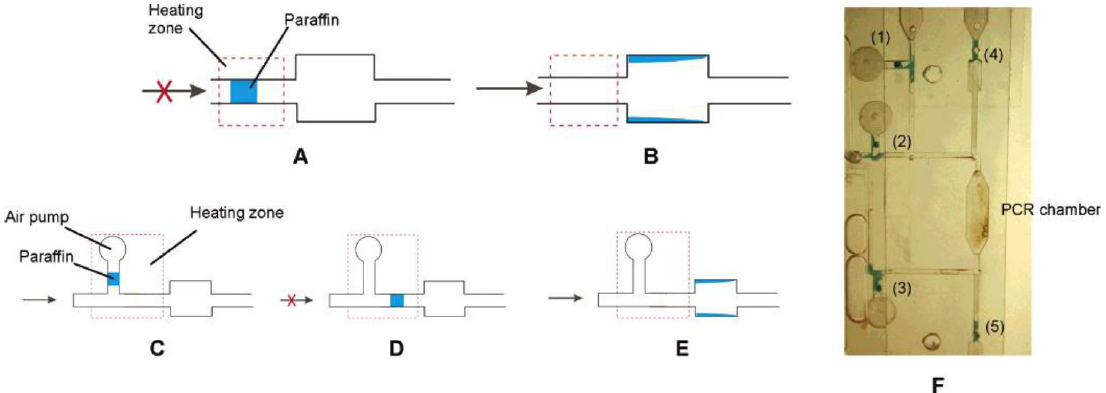
Figure 4. ( a – b ) Schematic illustrations of a close-open paraffin microvalve